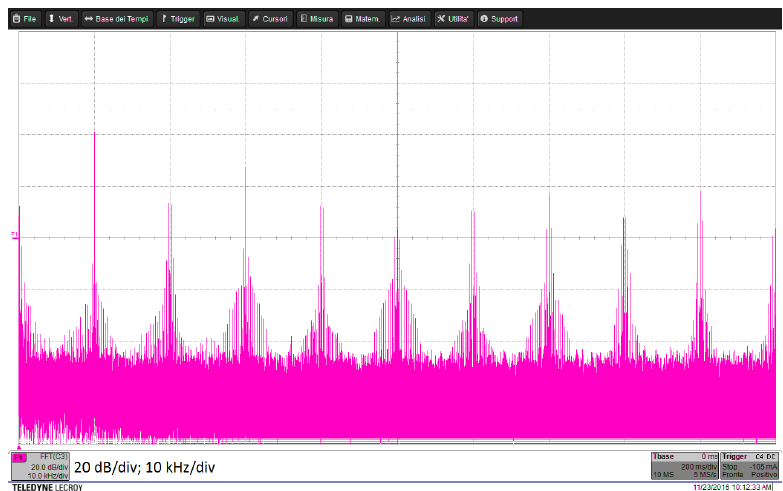
Figure 10. CMV spectrum; H6 architecture and SVPWM. Modulation index m = 0.4. Frequency range of 0–100 kHz.